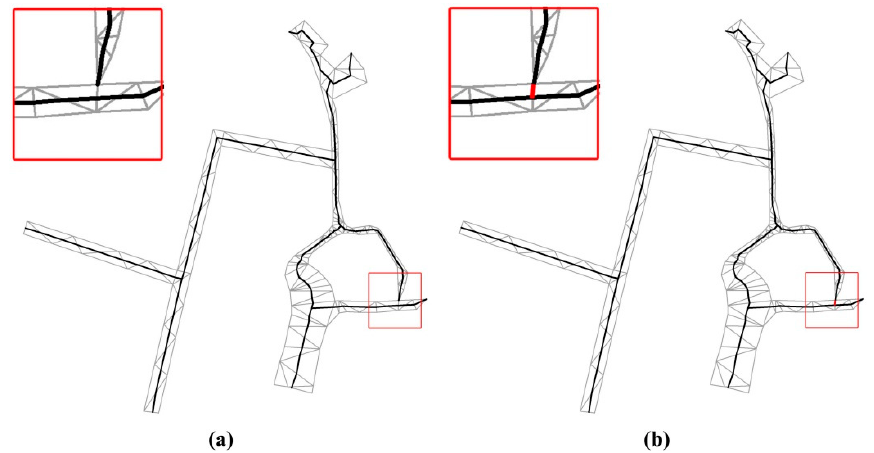
Figure 17. Case 3: Self-intersection of narrow and long patches: ( a ) skeleton line extracted directly and ( b ) split line topology correction.